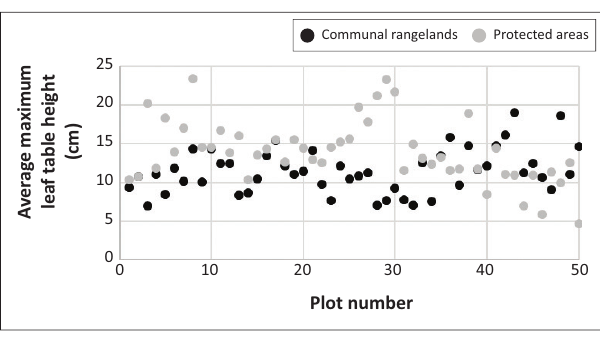
FIGURE 2-A1: Scatter plot showing the relationship of average maximum leaf table per plot number of each land-use type (protected areas versus communal rangelands). Plot number increases with distance from water source (protected area) or gate (communal rangelands).